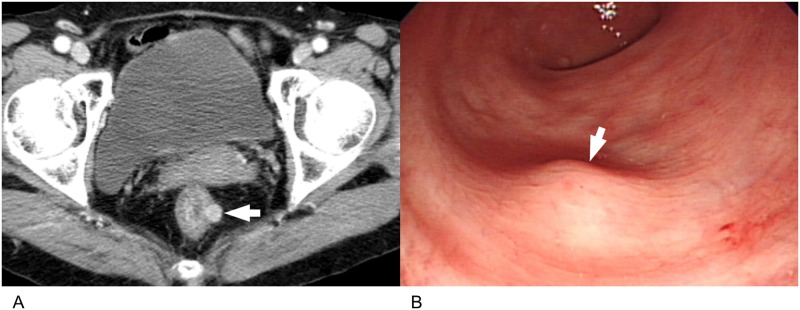
A 76-year-old woman with rectal schwannoma.(A). On portal phase axial CT image, a 1.1 cm round nodule (arrow) is seen at the rectum. The lesion shows homogeneously higher attenuation than back muscle with smooth margin. (B). Colonoscopy shows a smooth elevated subepithelial lesion (arrow) in the rectum.